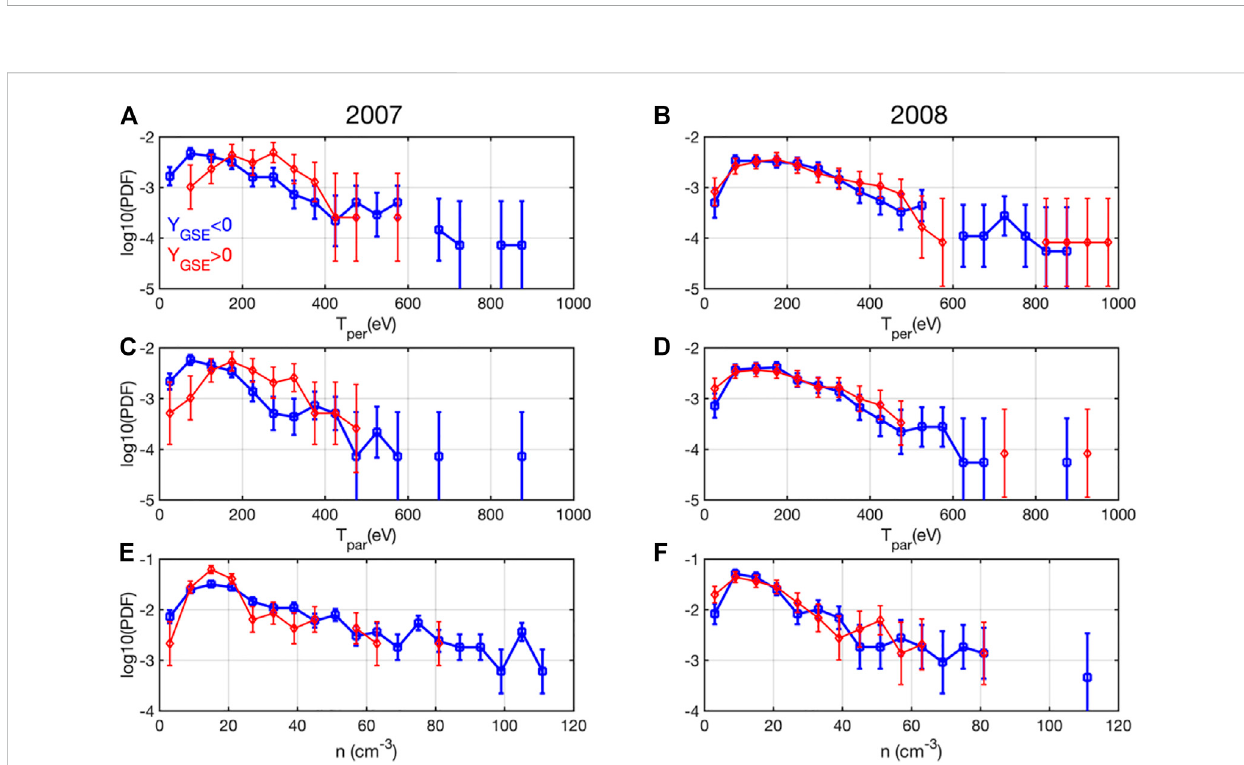
FIGURE 9 Histogramoftheionperpendicular[upperpanels, (A,B) ],parallel[lowerpanels, (C,D) ]temperatureandplasmadensity[lowerpanels, (E,F) ]for2007 (left) and 2008 (right). Blue/red pro fi les correspond to dawn (Y < 0)/dusk (Y > 0) fl anks,